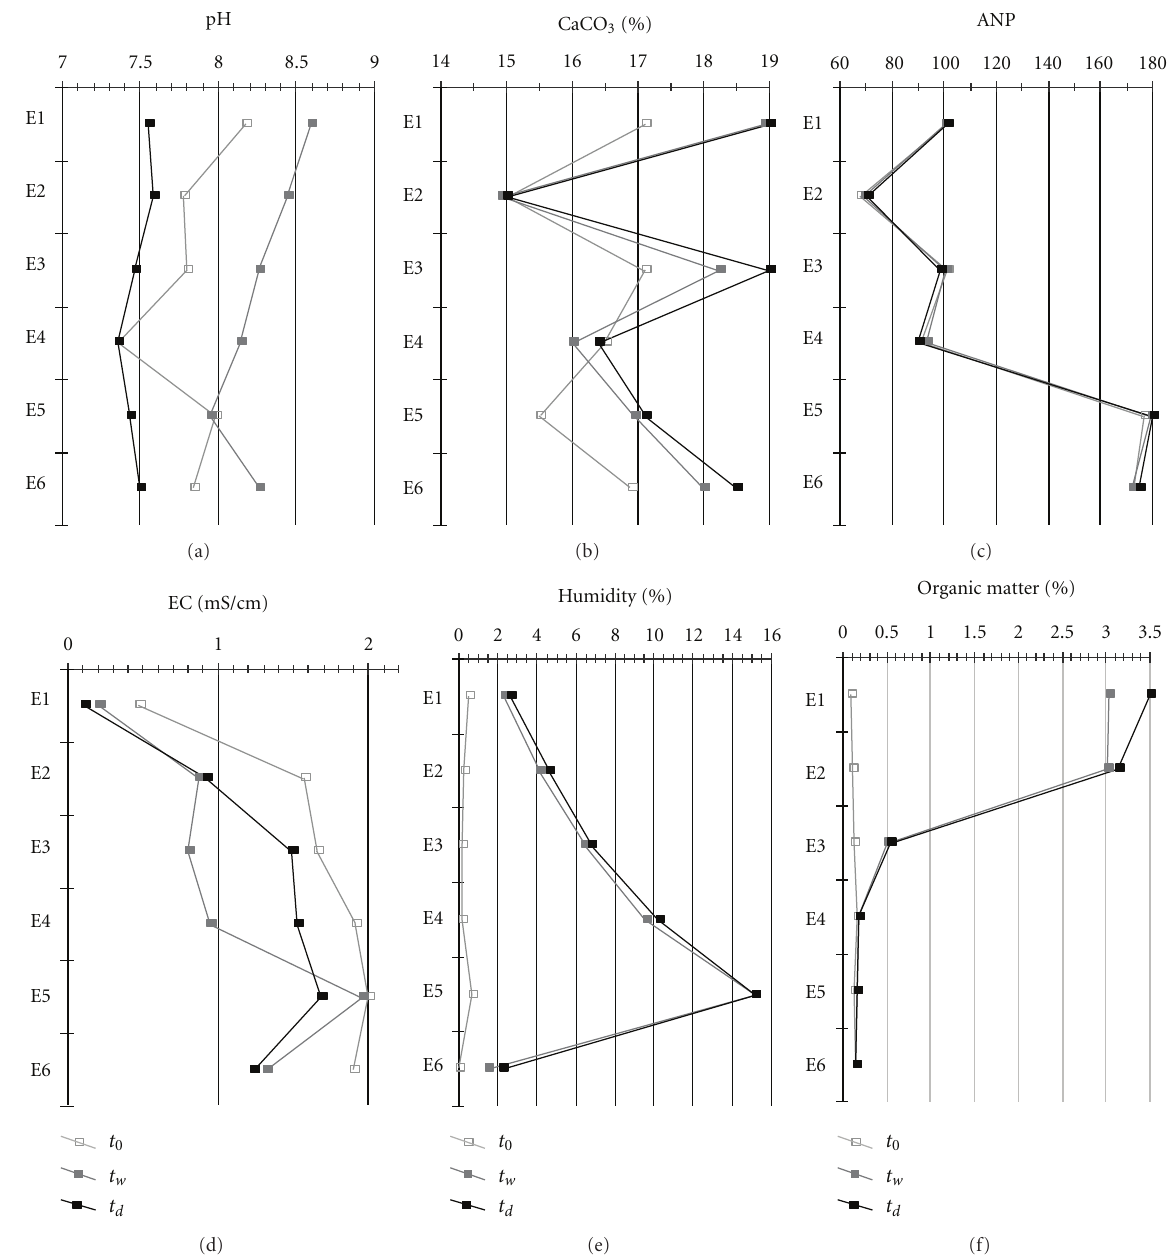
Figure 5: pH, % calcium carbonate (CaCO 3 ), acid-neutralization potential (ANP, in CO 32 − /ton), electric conductivity (EC, in mS/cm), % humidity, and % organic matter of strata E1 to E6 before the assay ( t 0 ; light gray and open squares) and after the wet ( t w ; dark gray) and dry ( t d ; black) seasons. Data: average, n =